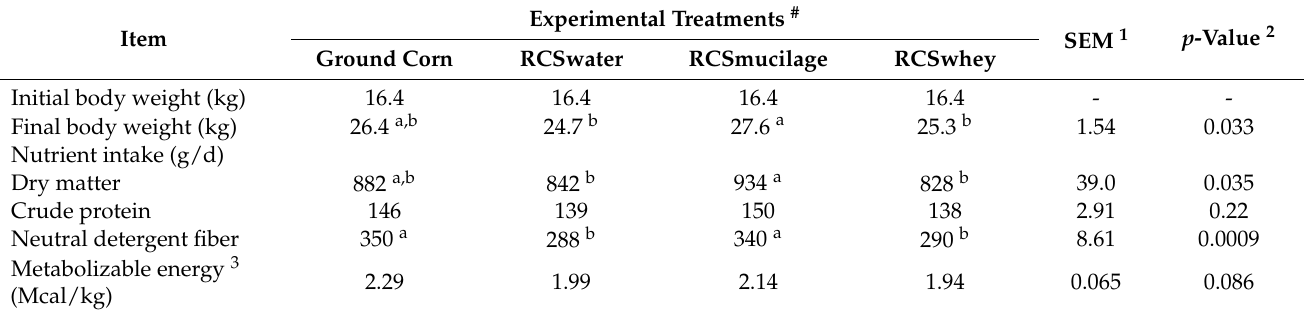
Table 3. Performance of goat kids fed with dry corn grain and ground-corn-grain silage rehydrated with different